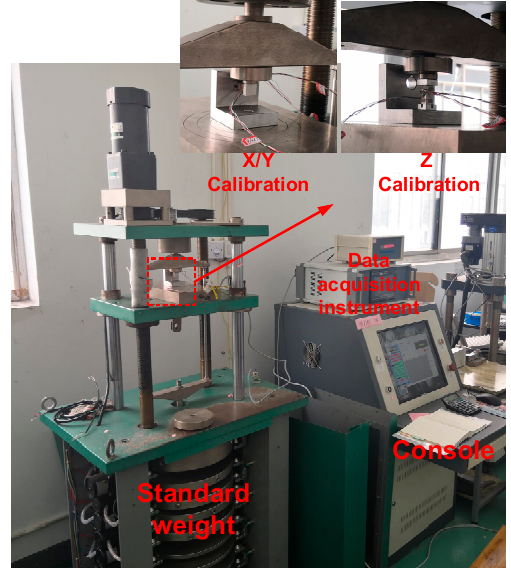
Figure 6. Calibration test bench.